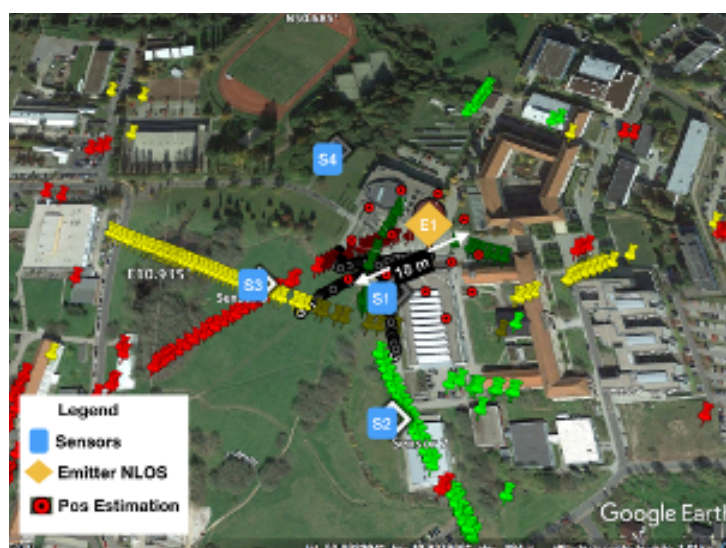
Figure 25. Final position estimation error with machine learning